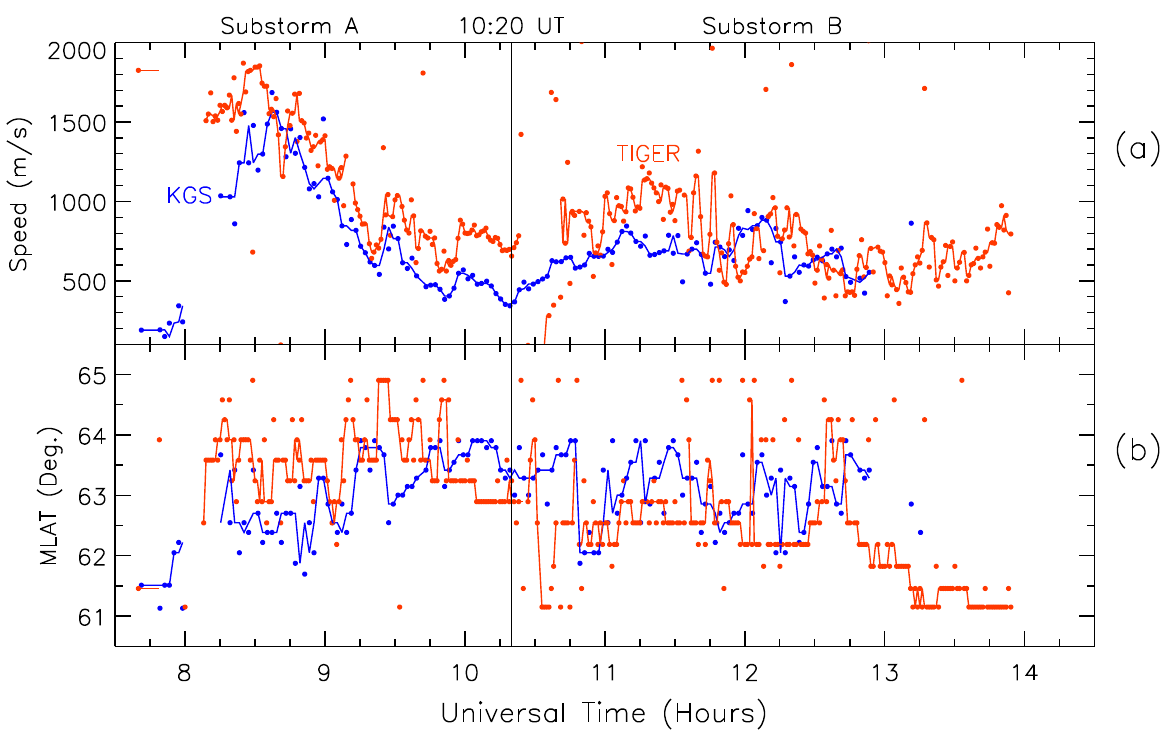
Fig. 9. (a) The maximum speeds identified within the latitude range 61 ◦ to 65 ◦ 3 along KGS beam 2 (blue) and TIGER beam 14 (red). This latitude range selects peak speeds within the scatter associated with the AWFCs (cf. Fig. 7). The speeds were scaled up to allow for difference between the orientation of the radar beams and the AWFC (see text). (b) The bold dots show the AACGM latitude of the corresponding group ranges of the results shown in (a). The continuous curves were obtained by applying a median filter of dimension 3 in the time